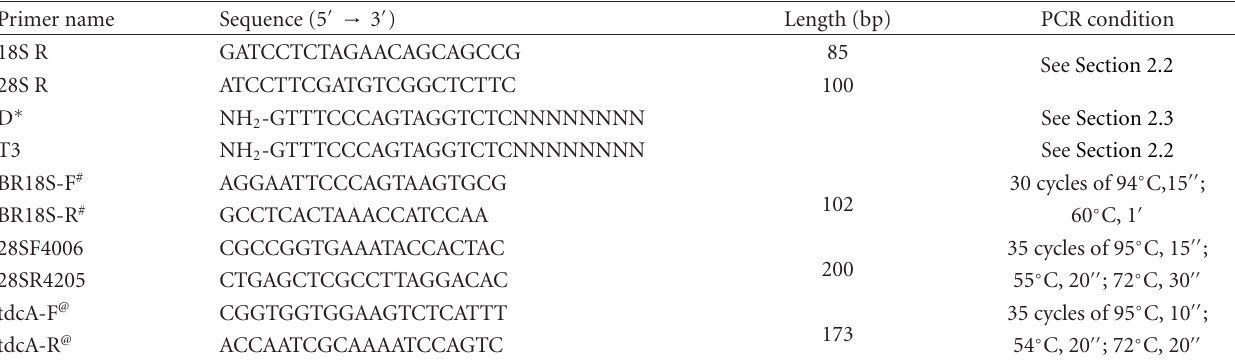
Table 1: List of primers used in this study for the generation of capture probes and quantitative real-time reverse transcriptase